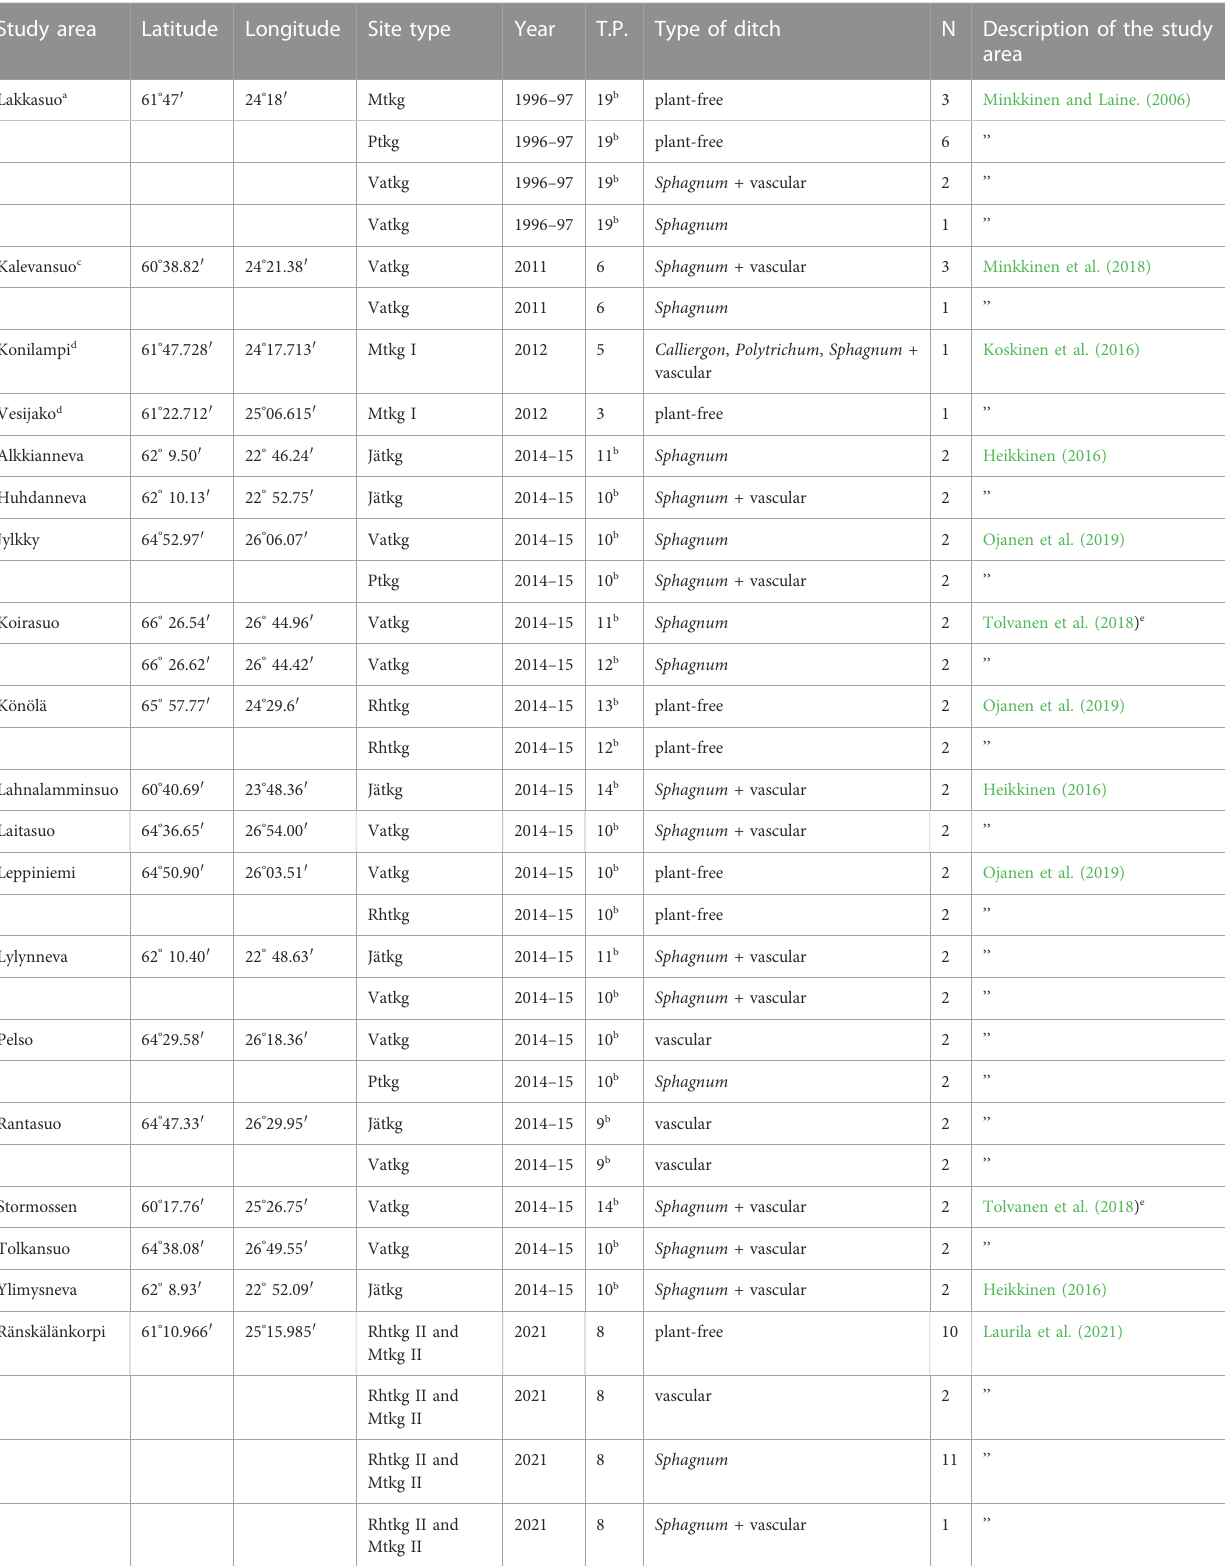
TABLE 1 Study areas (their location and nutrient status), year of CH 4 fl ux measurements, number of measurement timepoints during snow-free season (T.P.), the types of ditches, number of measurement points belonging to the particular type of ditch (N), and reference for the description of the study area. Site types from the nutrient richest to the nutrient poorest type with their abbreviations (Laine et al., 2012): Herb-rich (Rhtkg), Vaccinium myrtillus (Mtkg), Vaccinium vitis-idaea (Ptkg), Dwarf-shrub (Vatkg), Lichen (Jätkg). I and II describe the status of the tree stand prior drainage, if known: treed (I), sparsely treed or treeless (II). CH 4 fl ux data from four (i.e., Lakkasuo, Kalevansuo, Konilampi and Vesijako) out of the total of 21 study areas was previously published (see references in